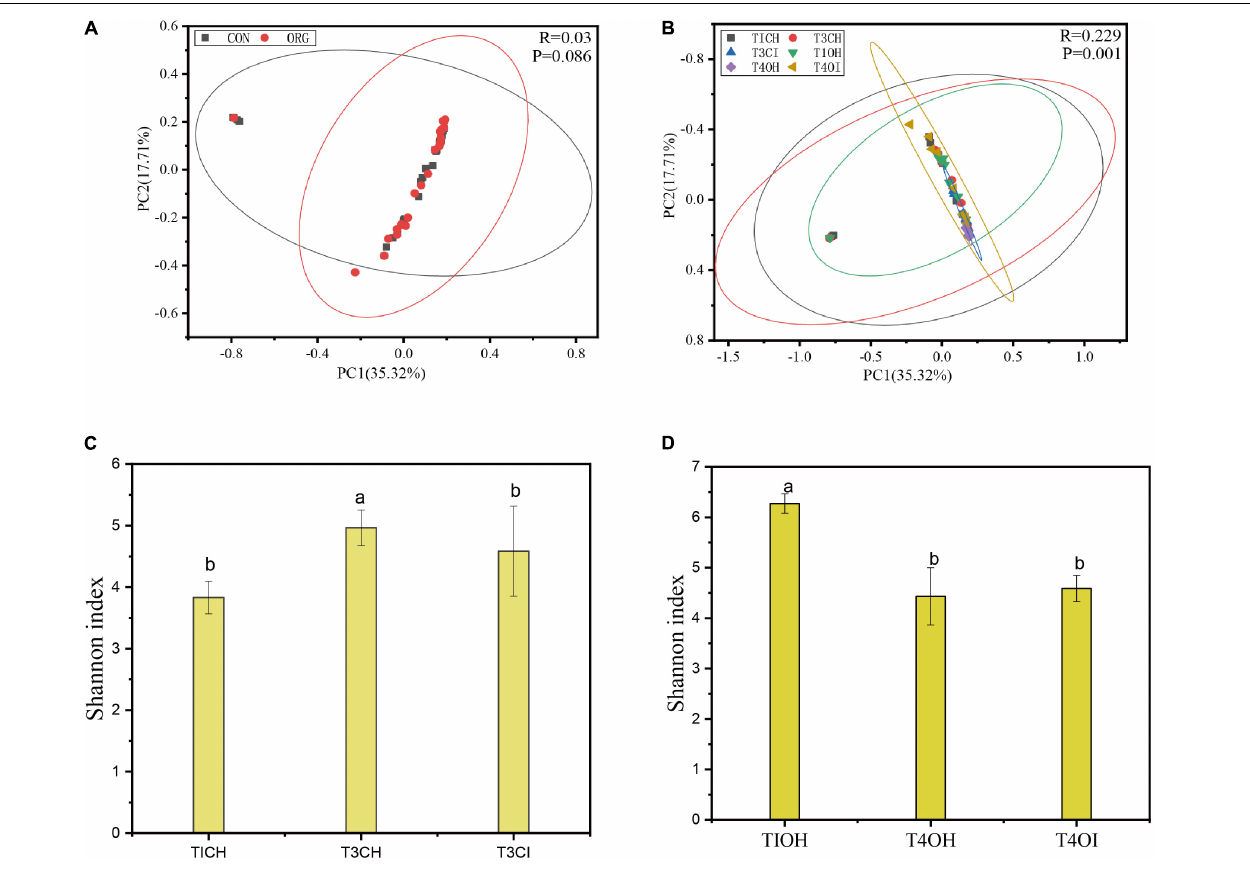
FIGURE 4 | (A) PCoA of bacterial microbiota using Bray–Curtis distance for organic and conventional agricultural practice. ORG stands for organic greenhouse. CON stands for conventional greenhouse. (B) PCoA of bacterial microbiota using Bray–Curtis distance for healthy and diseased plants. (C) OTU bacterial Shannon diversity index for different treatments at organic greenhouse. (D) OTU bacterial Shannon diversity index for different treatments at conventional greenhouse. TIOH stands for initially healthy plants in the organic system greenhouse, T4OH stands for healthy plants in the organic system greenhouse. T4OI stands for diseased plants in the organic system greenhouse. TICH stands for initially healthy, T3CH stands for healthy at last, and T3CI stands for diseased at last in the conventional greenhouse. T1, seedling phase; T3, fruiting phase; T4, harvesting phase. Different letters denote dramatically significant ( p <